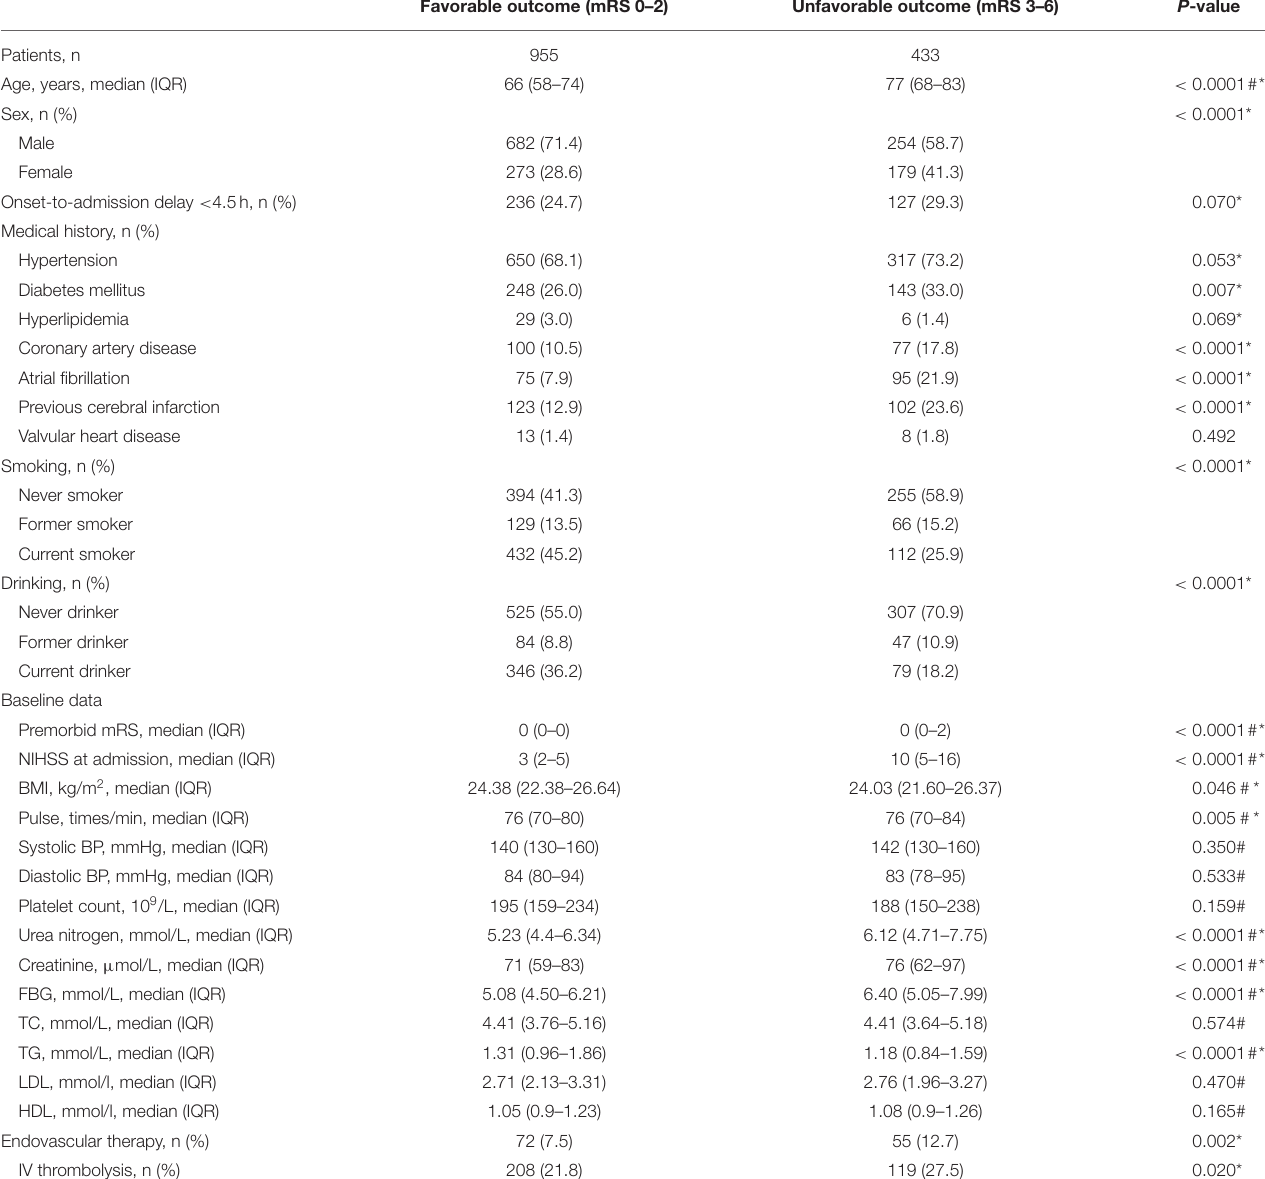
TABLE 1 | Clinical, demographic and laboratory data of the patients in the training set stratified according to 6-month favorable or unfavorable outcome after acute ischemic